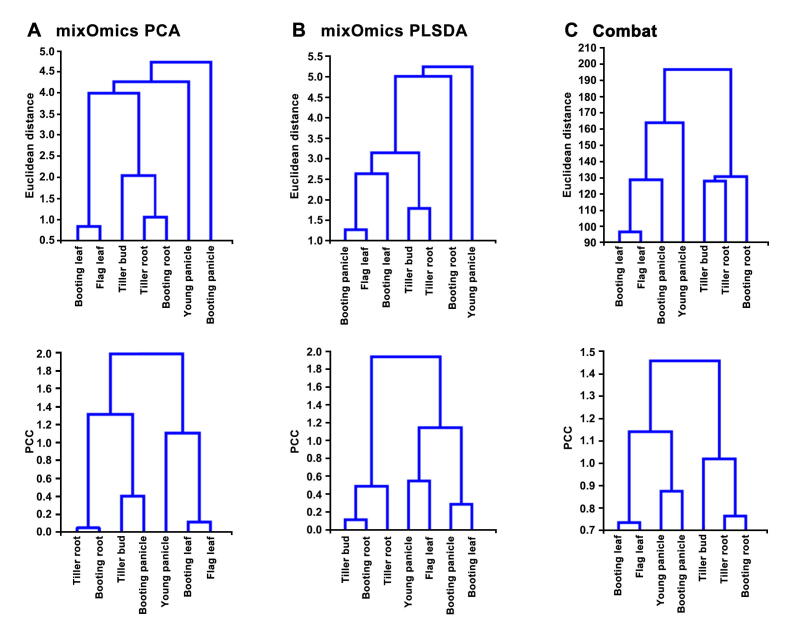
Comparison of the seven tissue associations (Euclidean distance or Pearson’s correlation) using three different methods. mixOmics PCA (A), PLSDA (B), Combat (C). PCC, Pearson’s correlation coefficient; mixOmics PCA, mixOmics principal component analysis; PLSDA, partial least squares-discriminant analysis.